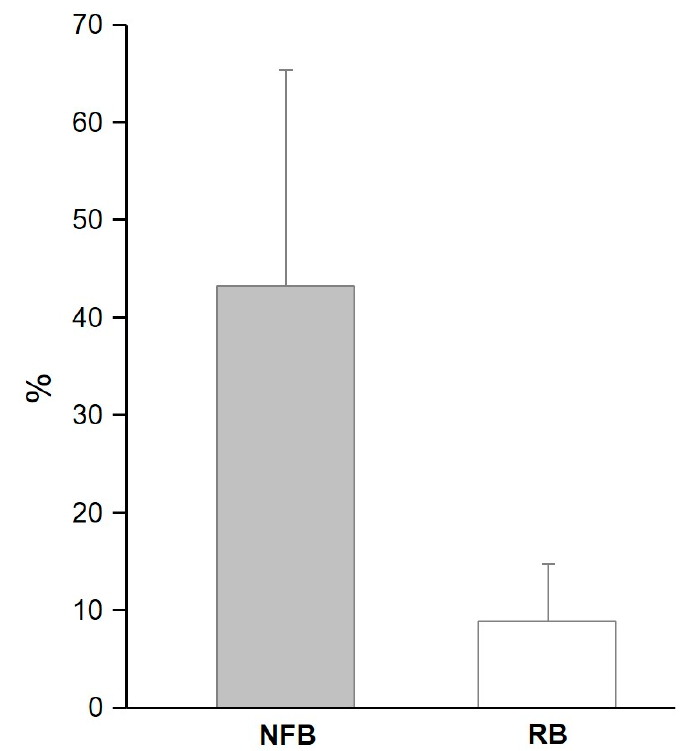
Figure 4. Newly Formed Bone (NFB, %) and Residual Biomaterial (RB %) in sockets grafted with EDEBEX. Data are presented as mean ± SD. Table 2. Outcome at final follow-up according to the Albrektsson and Zarb [25] criteria. In particular, these criteria were: (1) absence of persistent pain, dysesthesia, or paresthesia in the implant area; (2) absence of peri-implant infection with or without suppuration; (3) absence of perceptible mobility of the implant; (4) absence of peri-implant bone resorption greater than 1.5 mm during the first